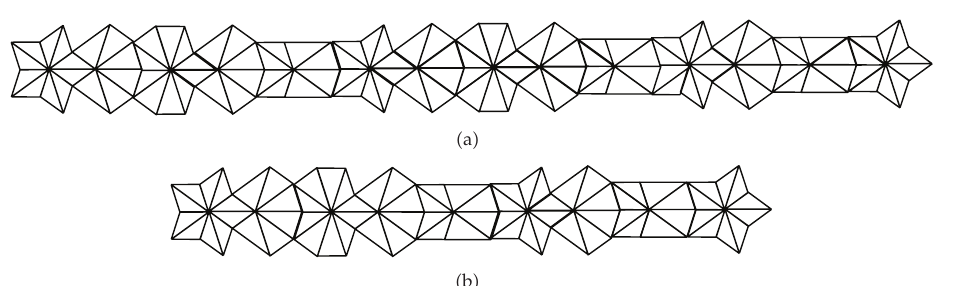
Figure 12: Vertex sequences in the level-6 superedges of types α (cid:6) a (cid:7) and β (cid:6) b (cid:7) in T (cid:8)